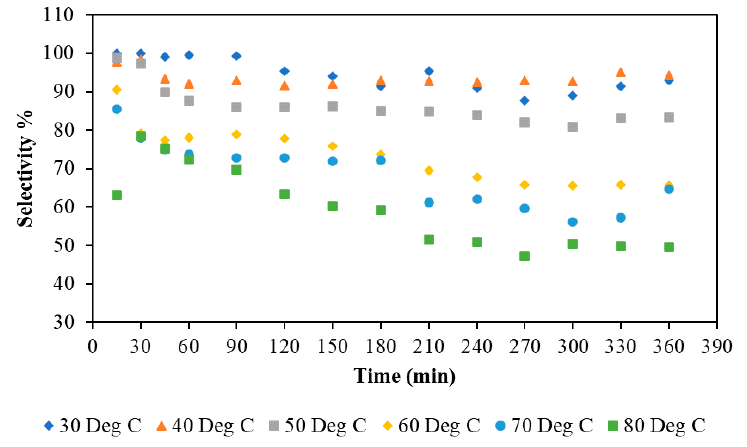
Figure 8. Effect of temperature on the selectivity. Epichlorohydrin 0.1 mol, n-decane 0.03 mol, toluene 150 cm 3 , guaiacol 0.1 mol, sodium hydroxide 0.2 mol, sodium chloride 0.6 mol, tetra-n-butylammonium bromide 0.14 mol, and water 150 cm 3 . Speed of agitation 60 rpm for all three phases and reaction time 6 h.